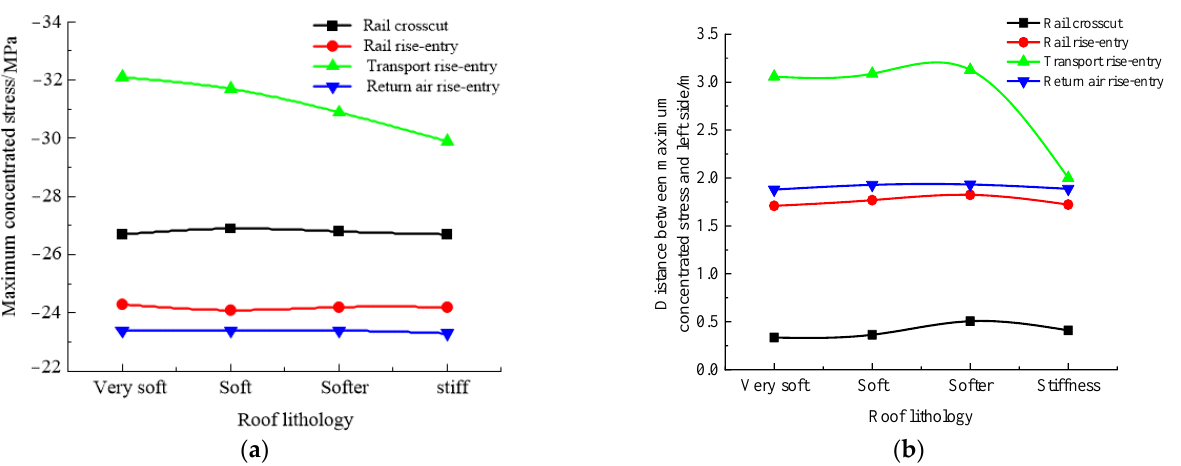
Figure 9. Maximum concentrated stress and its location monitoring results under different roof lithology conditions. ( a ) Maximum concentrated stress, ( b ) Position of maximum concentrated stress. It can be seen from Figure 9 that with the continuous enhancement of roof lithology, for the maximum concentrated stress of the three roadways of the − 706-rail crosscut, rail rise-entry, and return air rise-entry, the distance between their position and the left side of the roadway did not change much. The maximum concentrated stress of transport rise- entry showed a decreasing trend, but the distance between the maximum concentrated stress and the left side of the roadway was unchanged when the roof lithology was very soft, soft, and softer. Only when the roof lithology changes from softer to stiff will the distance between the maximum concentrated stress and the left side of the roadway be greatly reduced.